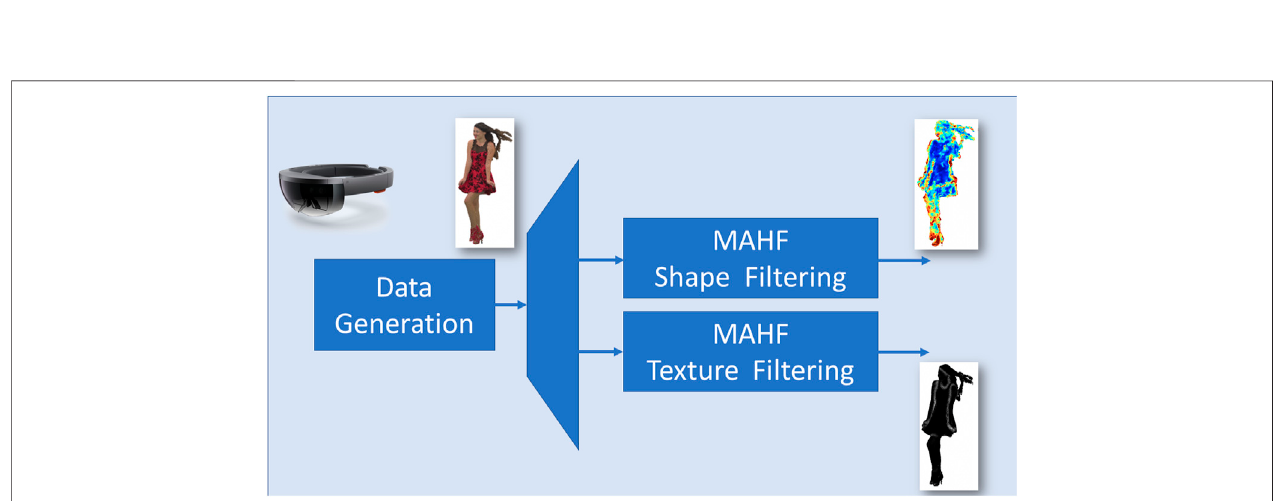
FIGURE 2 | Graphical representation of angles in the 3 D space. In panel (A), we represent the continuous manifold M , in which we highlight the angle ϑ ( M ) in orange. In panel (B), we have the discrete manifold on which a graph G is de fi ned. The angle ϑ ( G ) is plotted in orange.